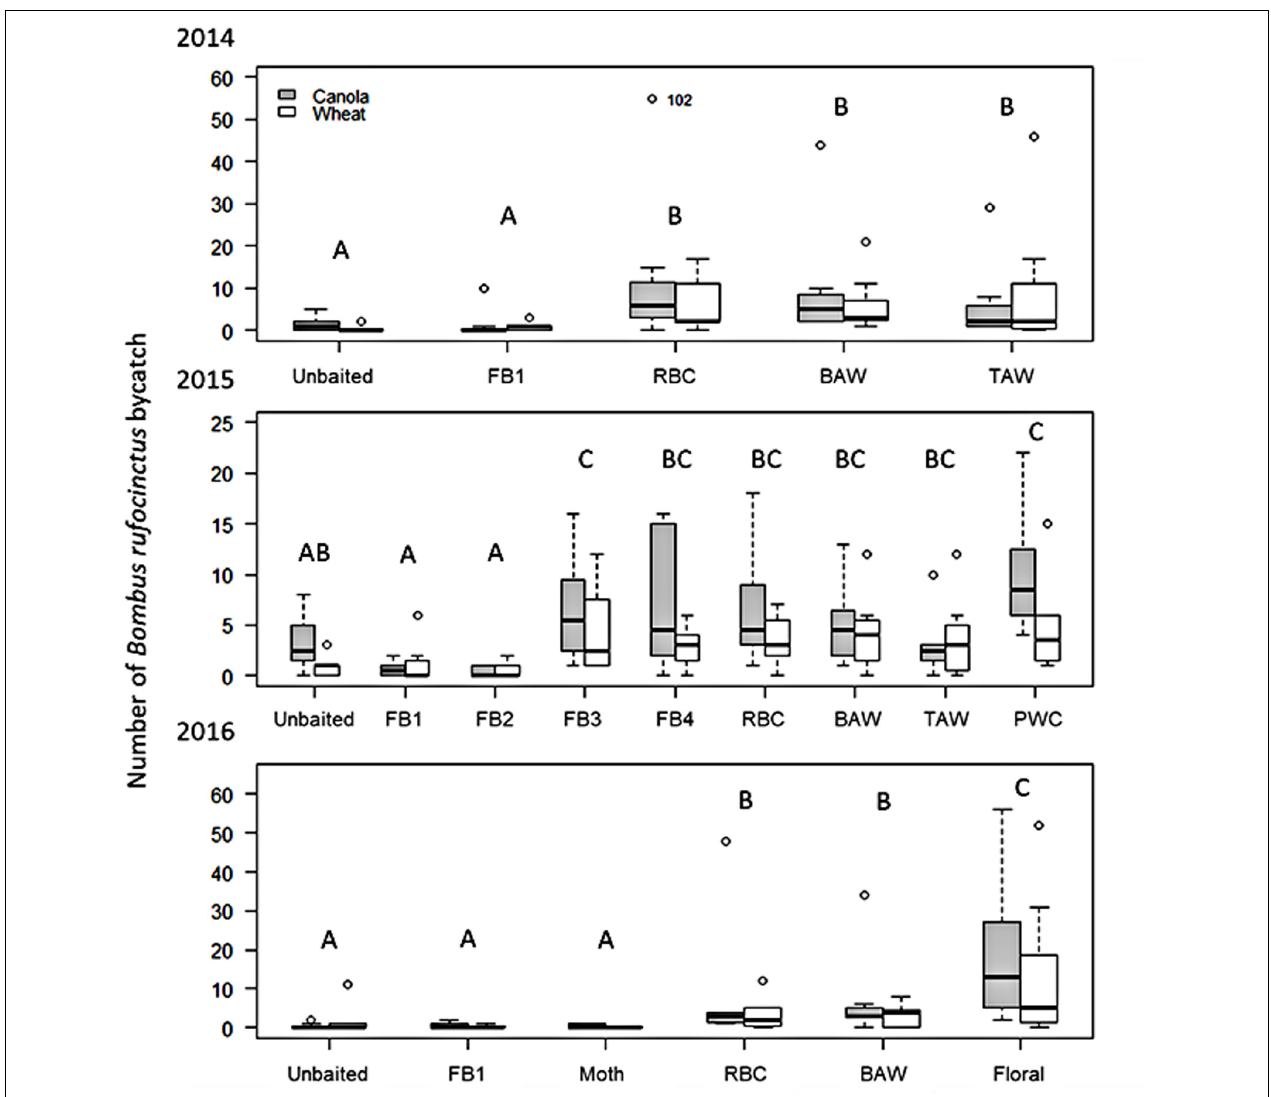
FIGURE 1 | Boxplots of the season long capture of Bombus rufocinctus in baited Unitraps at canola and wheat crops in central Alberta, Canada between 2014 and 2016. Lure treatments varied by season. 2014: FB1 = acetic acid + 3-methyl-1-butanol; RBC = Redbacked cutworm pheromone; BAW = Bertha armyworm pheromone; TAW = true armyworm pheromone. 2015: FB1; FB2 = FB1 + 2-methyl-1-propanol; FB3 = FB1 + phenylacetaldehyde; FB4 = FB1 + 2-methyl-1-propanol + phenylacetaldehyde; RBC; BAW; TAW; PWC = Pale western cutworm pheromone. 2016: FB1; Floral = phenylacetaldehyde; Moth = 10 g previously captured dead noctuid moths; RBC; BAW. Open circles represent points more than 1.5 times the interquartile range (repositioned points are shown with the original location indicated to allow for easier visual comparison between treatments). Different letters indicate significant differences between treatments within year (Tukey’s HSD: p <